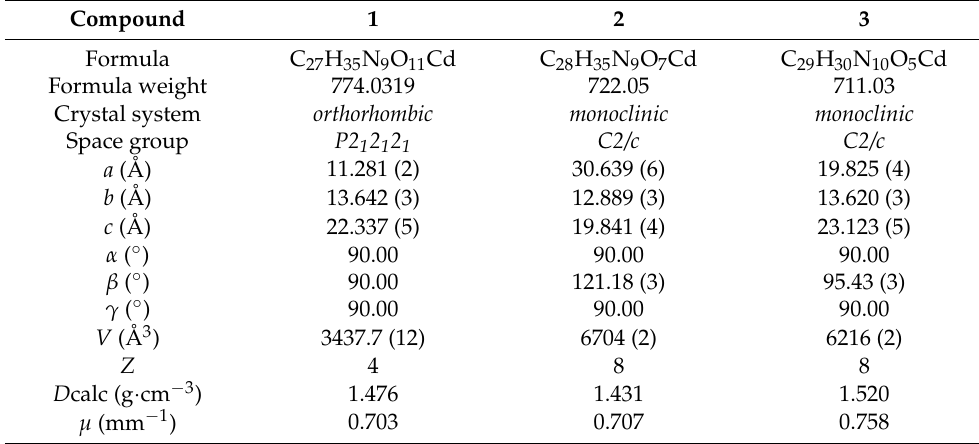
Table 1. Crystallographic parameters for compounds 1 – 3